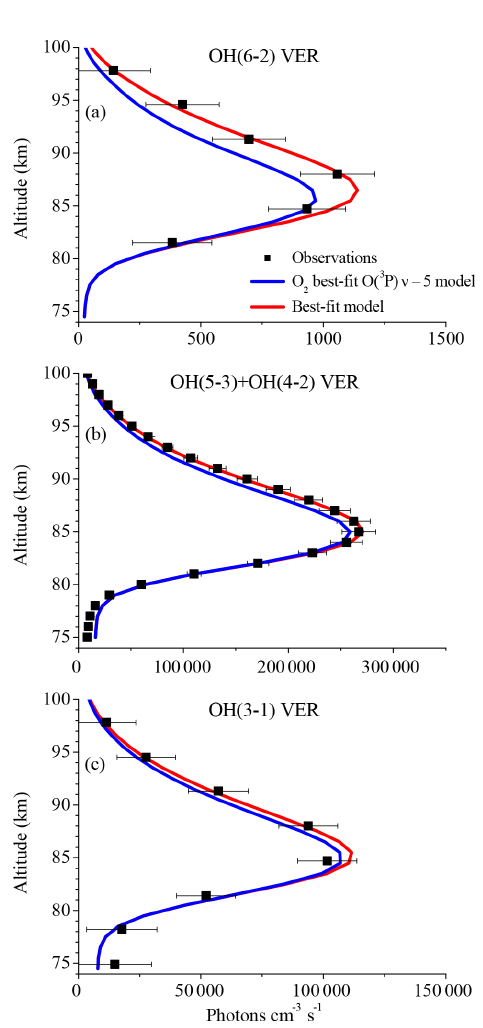
Figure 5. Same as Fig. 1 but for the O 2 best-fit O ( 3 P ) ν − 5 model and the best-fit